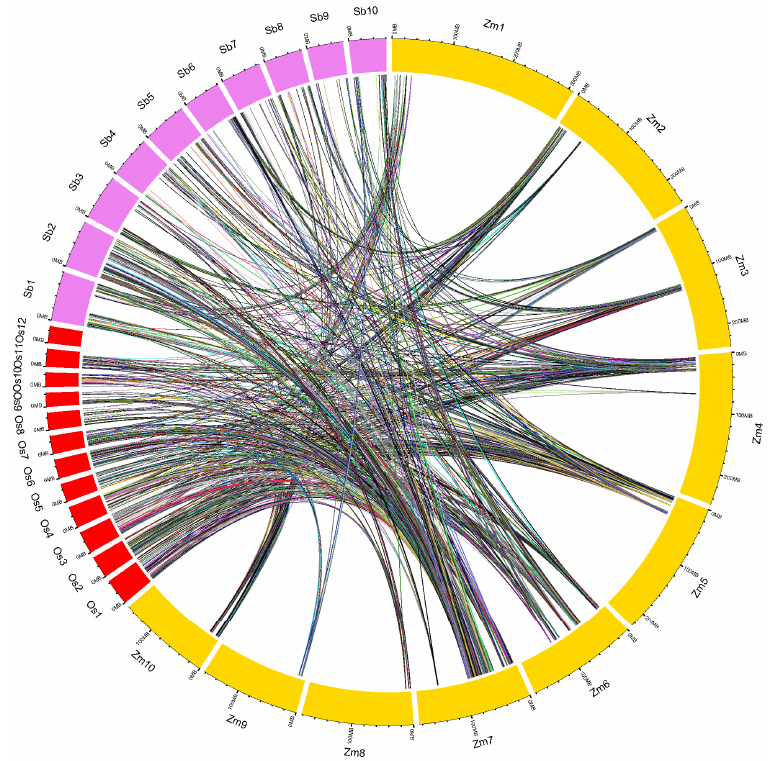
Figure 5. Conserved genomic regions among maize ( Zm ), rice (Os) and sorghum (Sb) genomes. The outer circles represent the maize (yellow), rice (red), and sorghum (violet) chromosomes. The linking lines represent the syntenic regions of maize–rice and maize–sorghum.